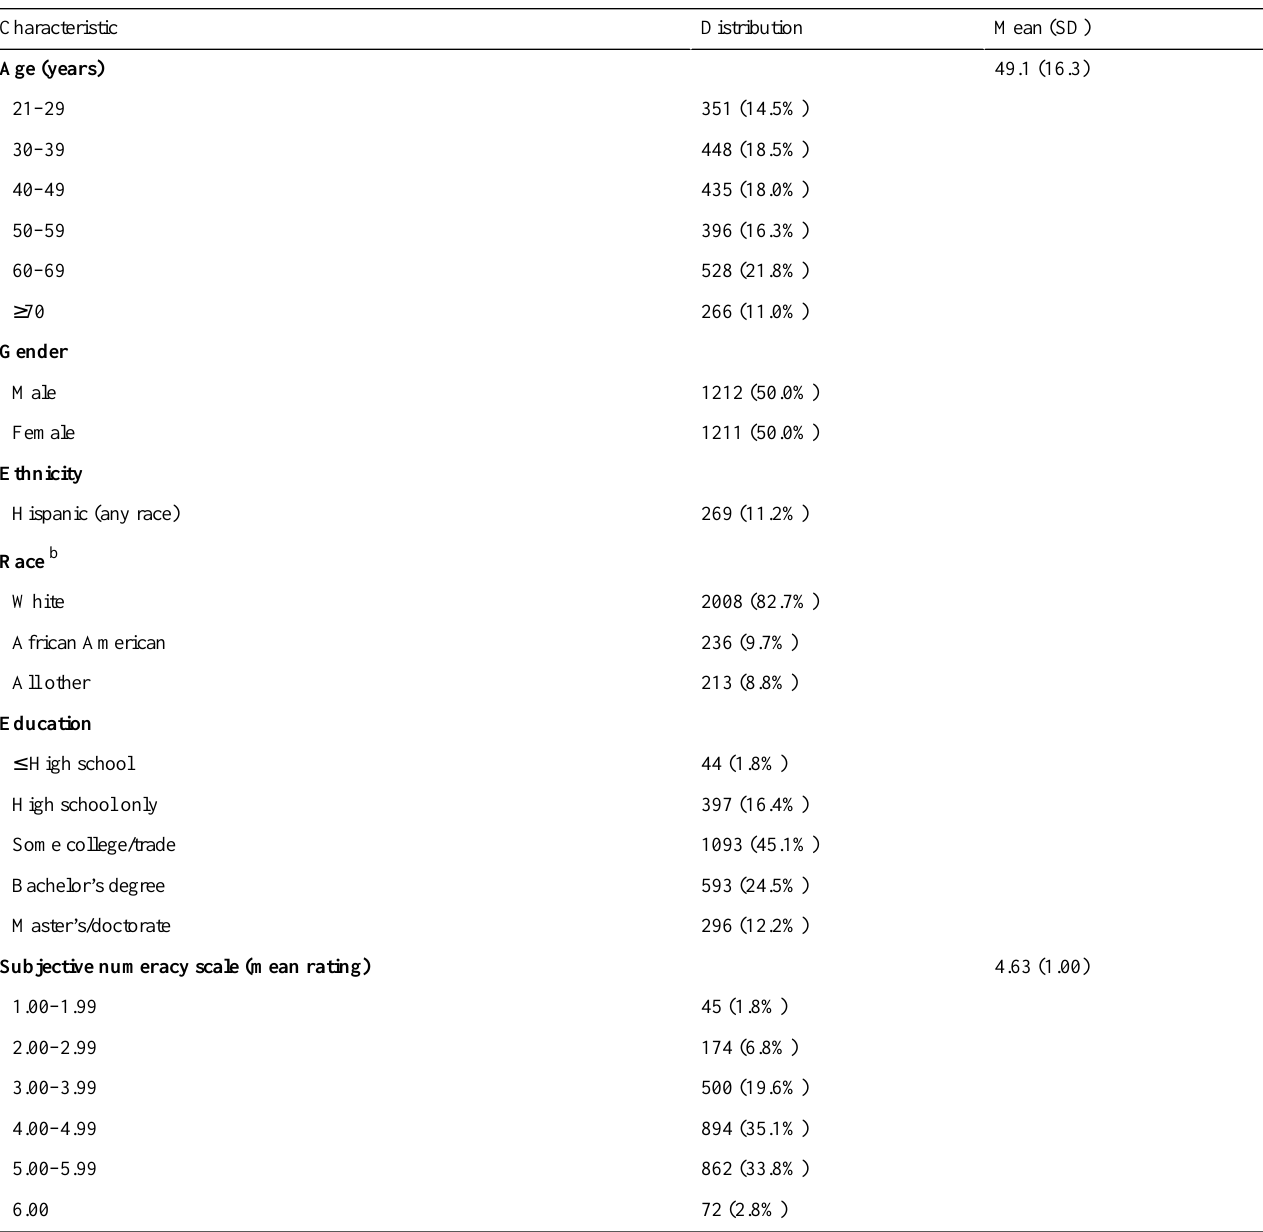
Table 2. Participanta demographic characteristics